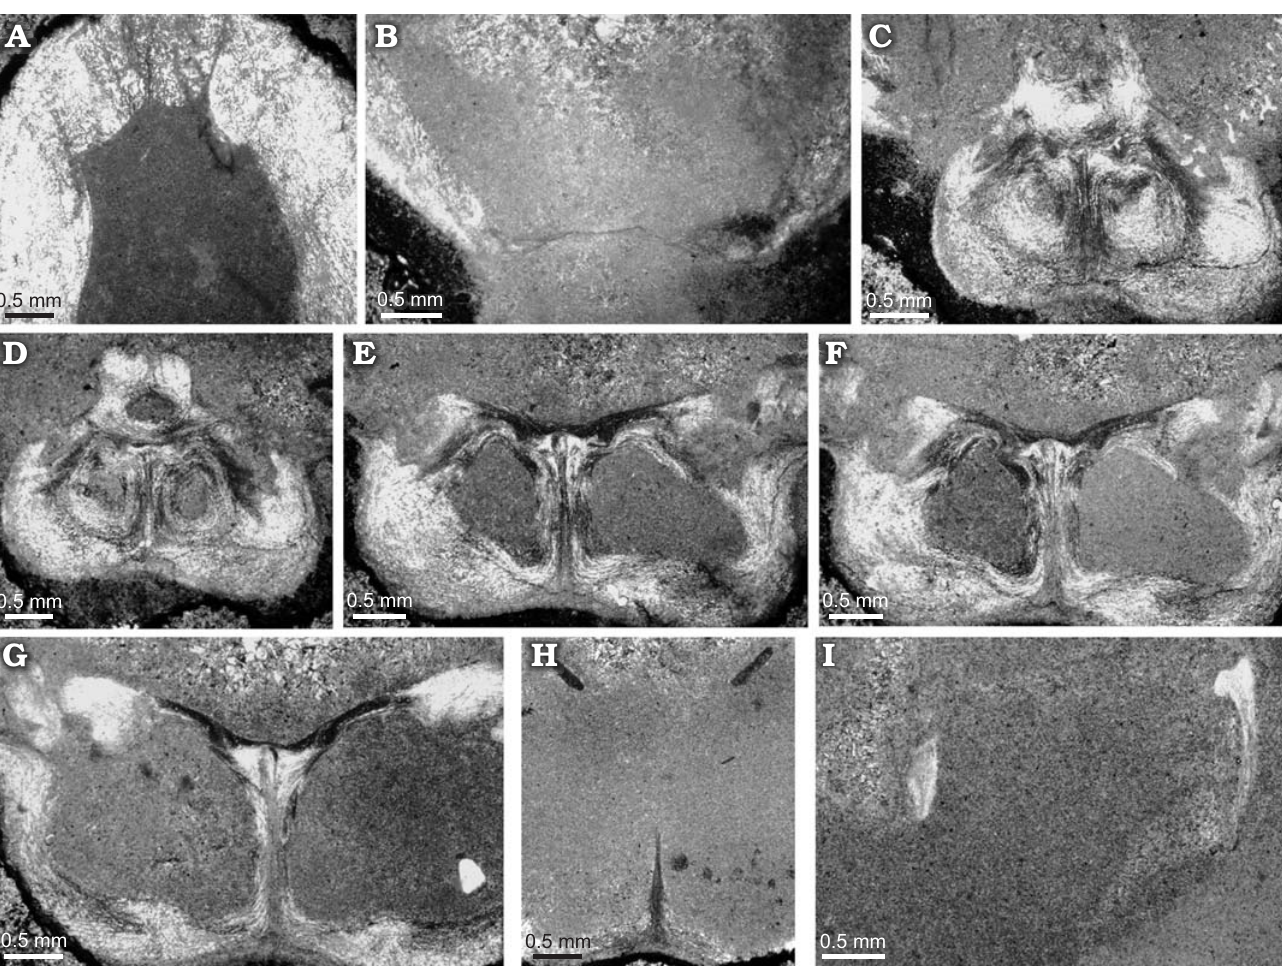
Fig. 5. Microphotographs of acetate peels from zeillerid brachiopod Misunithyris goyi gen. et sp. nov. (BQ-AH2.2) from the lower Ladinian of the South- Iberian Triassic platform, the Arroyo Hurtado section. A . Section at 1.00 mm from the apex showing dental lamellae enveloped in a thick-shelled wall. B . Section at 2.60 mm from the apex showing the disposition of deltidial plates. C , D . Sections at 3.30 and 3.50 mm from the apex, respectively, showing the first stages of hinge plates and earlier cardinalia and the evolution of the cardinal process, clearly striated and raised by a high cardinal platform. E , F . Sections at 4.10 and 4.30 mm from the apex, respectively, showing the cardinal area with the position of crural bases and the articulation system. G–I . Partial sections at 4.90, 5.70, and 7.10 mm from the apex, respectively, showing the evolution of the crural architecture and dorsal median septum riorly) multicostulate zeilleriids Tauromenia polymorpha , T.